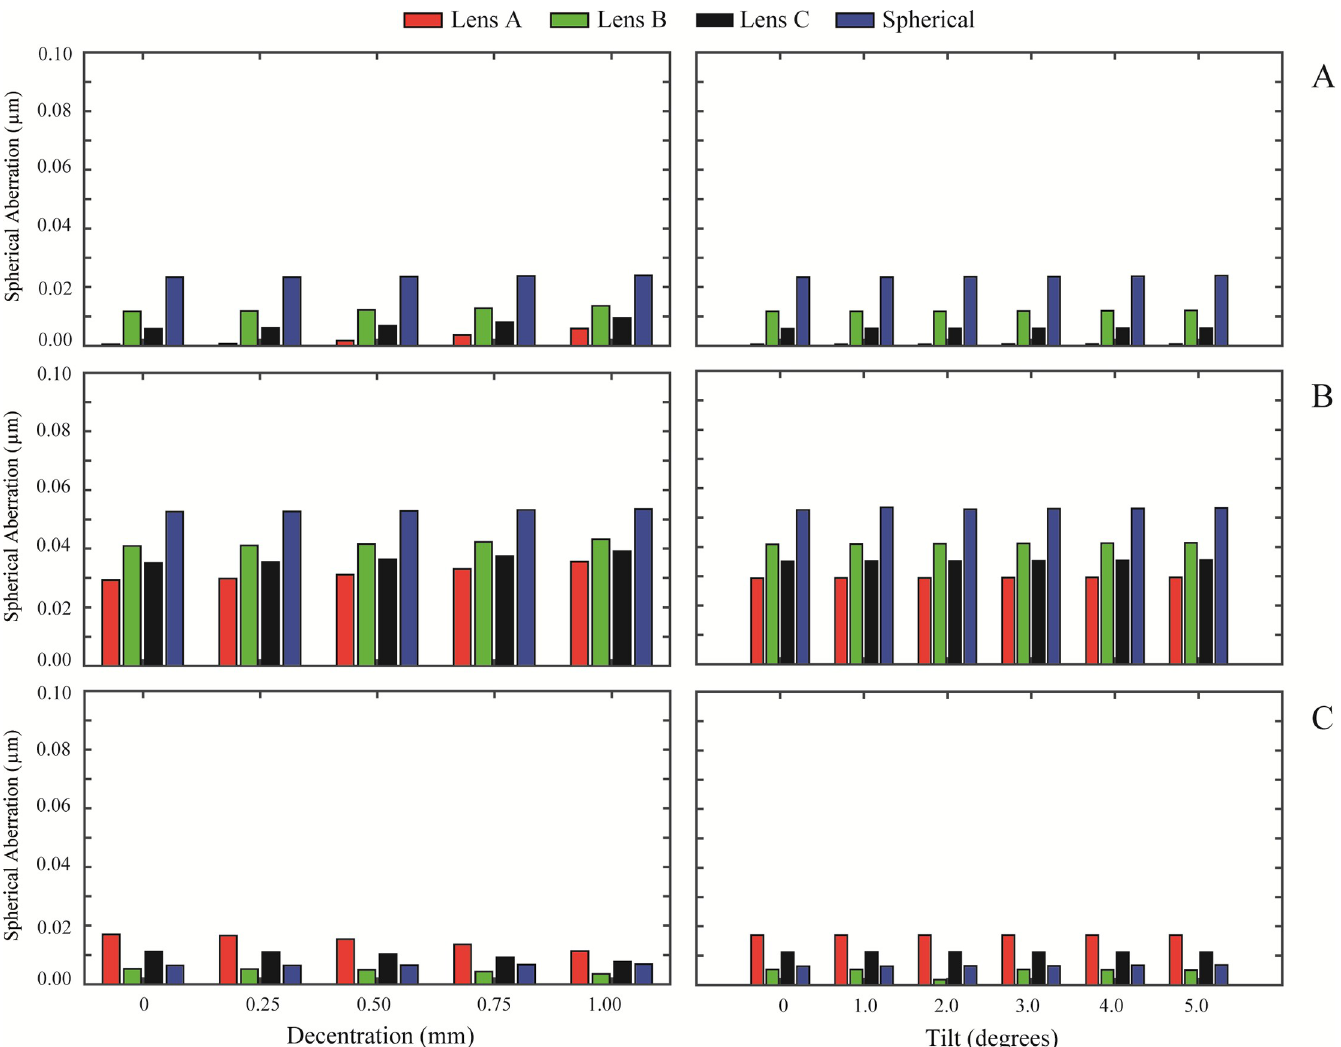
Fig 5. RMS spherical aberration ( Z 0 ) values of the designed IOLs for misalignment (left column) and tilt (right column) with each different cornea: A) Normal, B) 4 Myopic, C) Hyperopic.